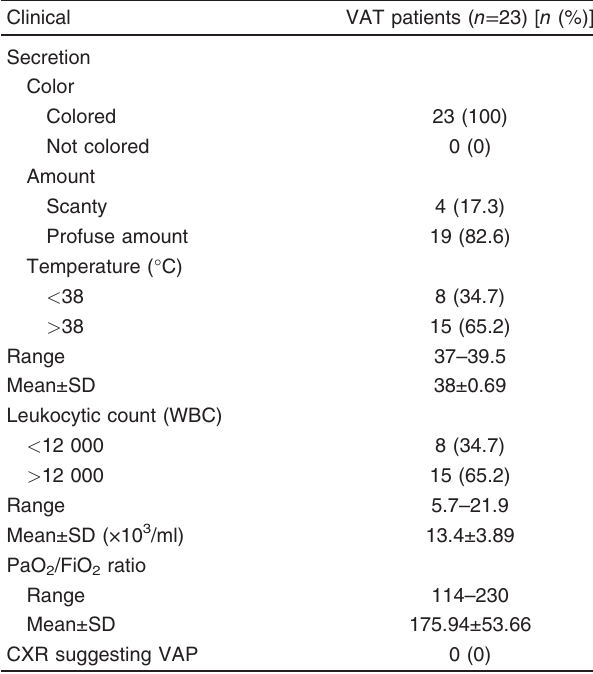
Table 4 Diagnostic criteria of ventilator-associated tracheobronchitis patients